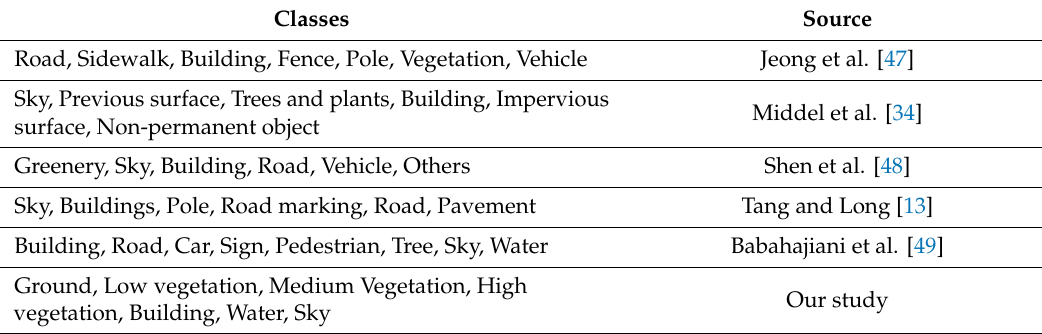
Table 3. Review of landscape features